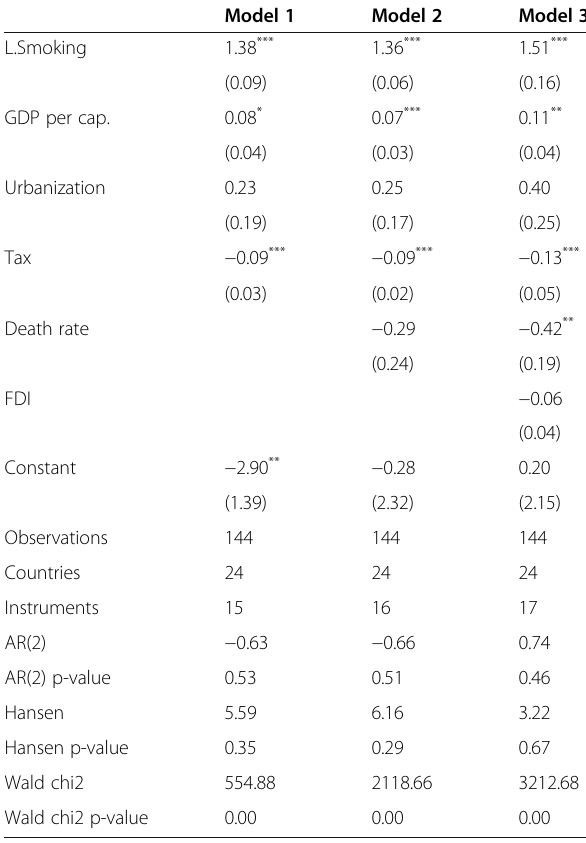
Table 6 The effect of tobacco tax on the prevalence of smoking Model 1 Model 2 Model